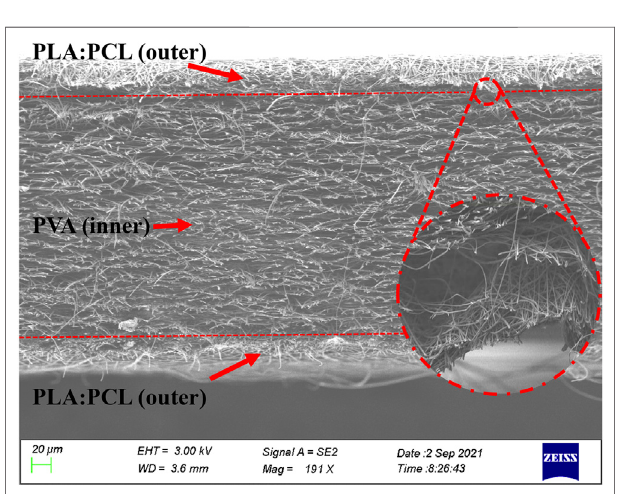
FIGURE 3 | Cross-section image of ML-S; the enlarged part is the interface details.